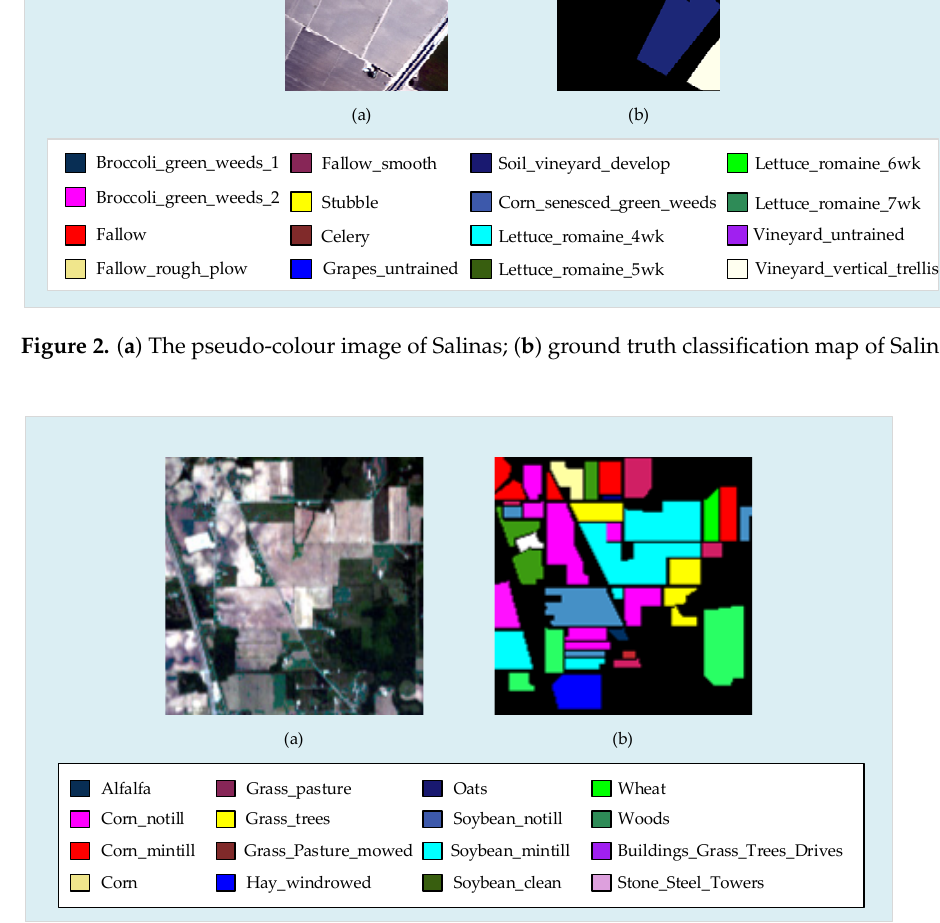
Figure 3. ( a ) The pseudo-colour image of Indian Pines; ( b ) ground truth classification map of Indian Pines.